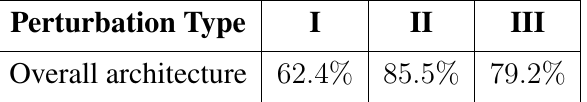
Table 3: Mean Validation Accuracy for Multi-class Classification